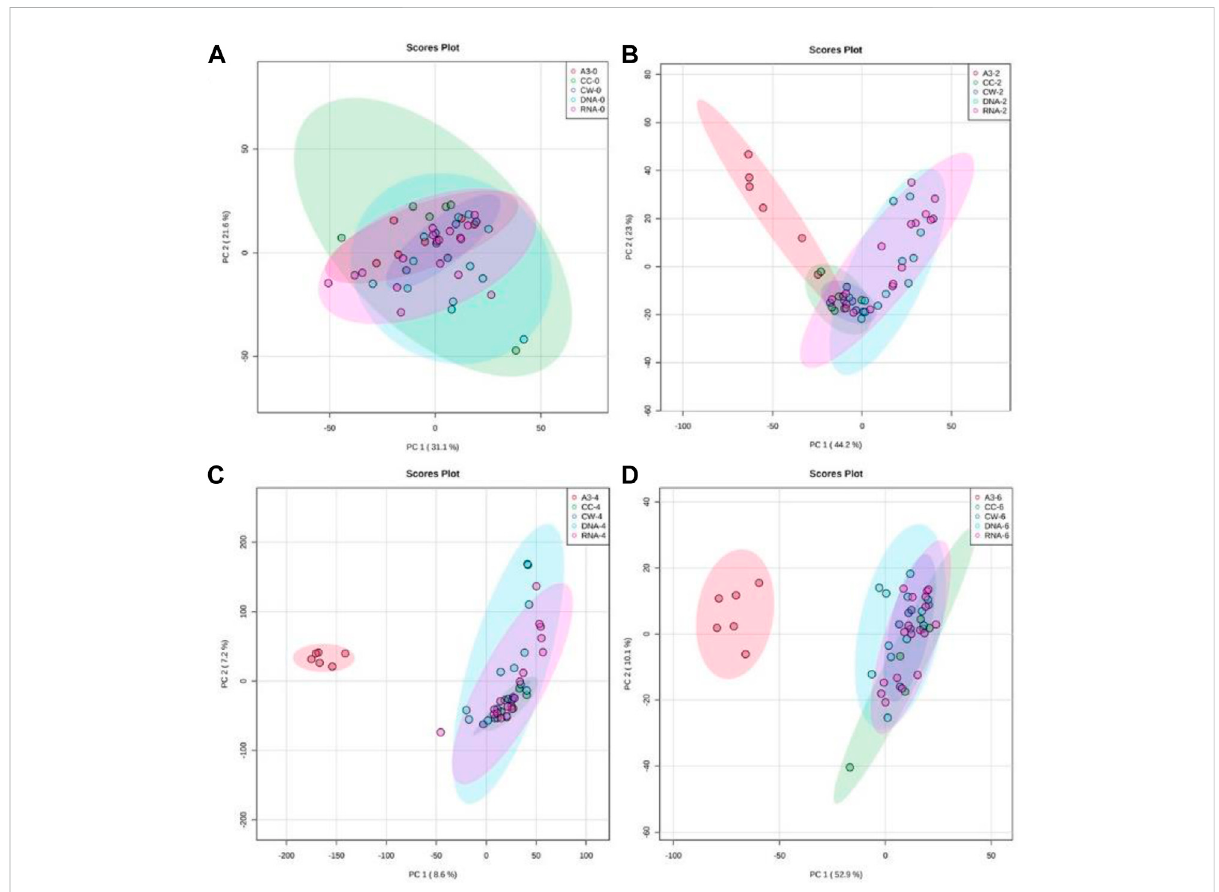
FIGURE 3 Principal component analysis (PCA) of antibiotic-treated MRSA metabolomes. PCA score plots (95% con fi dence interval is shown as paler colored ellipses) of normalized m/z intensities of metabolites extracted as detected by fl ow-infusion electrospray high-resolution mass spectrometry(FIE-HRMS).fromMRSAtreatedwithA3(Hb5d/e3)andcomparedtocontrolbacteria(CC)andtobacteriatreatedwithantibioticswitha similar mechanism of action, grouped into those with activity on cell wall (vancomycin, CW), on DNA (Levo fl oxacin and Nalidixic acid) and on RNA (Chloramphenicol, Gentamycin, and Streptomycin) for both positive and negative mode for time points (A) 0, (B) 2, (C) 4 and (D) 6